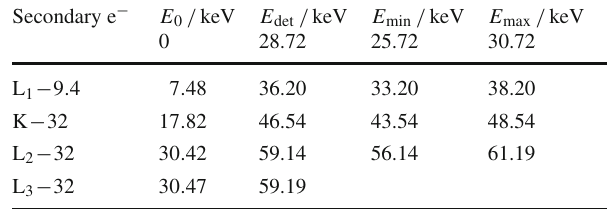
Table 1 Region of interest (ROI) for low-energy secondary electrons and high-energy primary electrons from 83m Kr decays, applied as an energy selection [ E min ; E max ] to the detector data. The L 2 , 3 − 32 lines are combined into one ROI